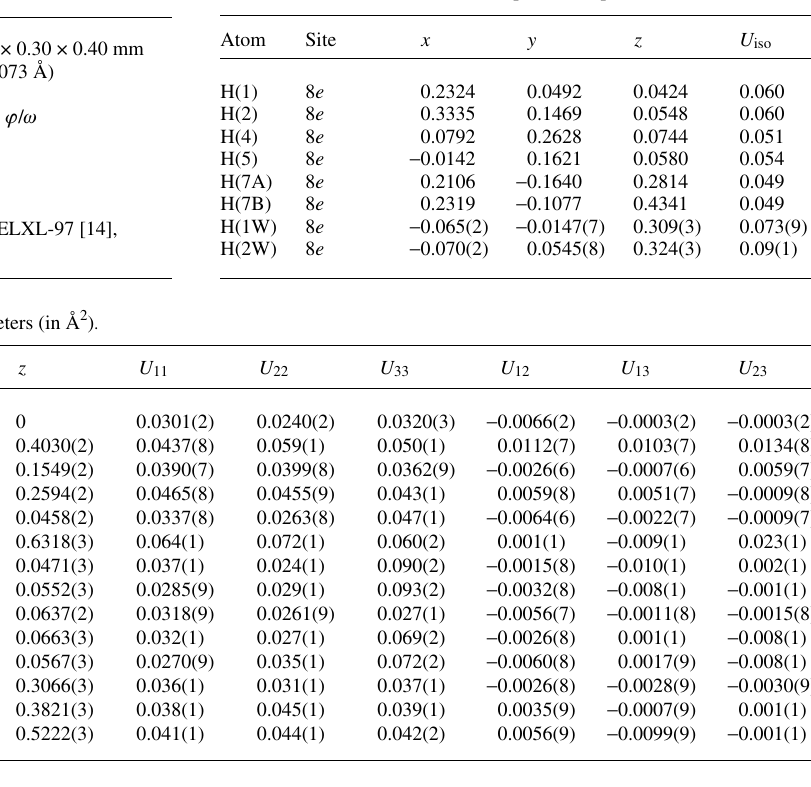
Table 2. Atomic coordinates and displacement parameters (in Å 2 ) . Table 1. Data collection and